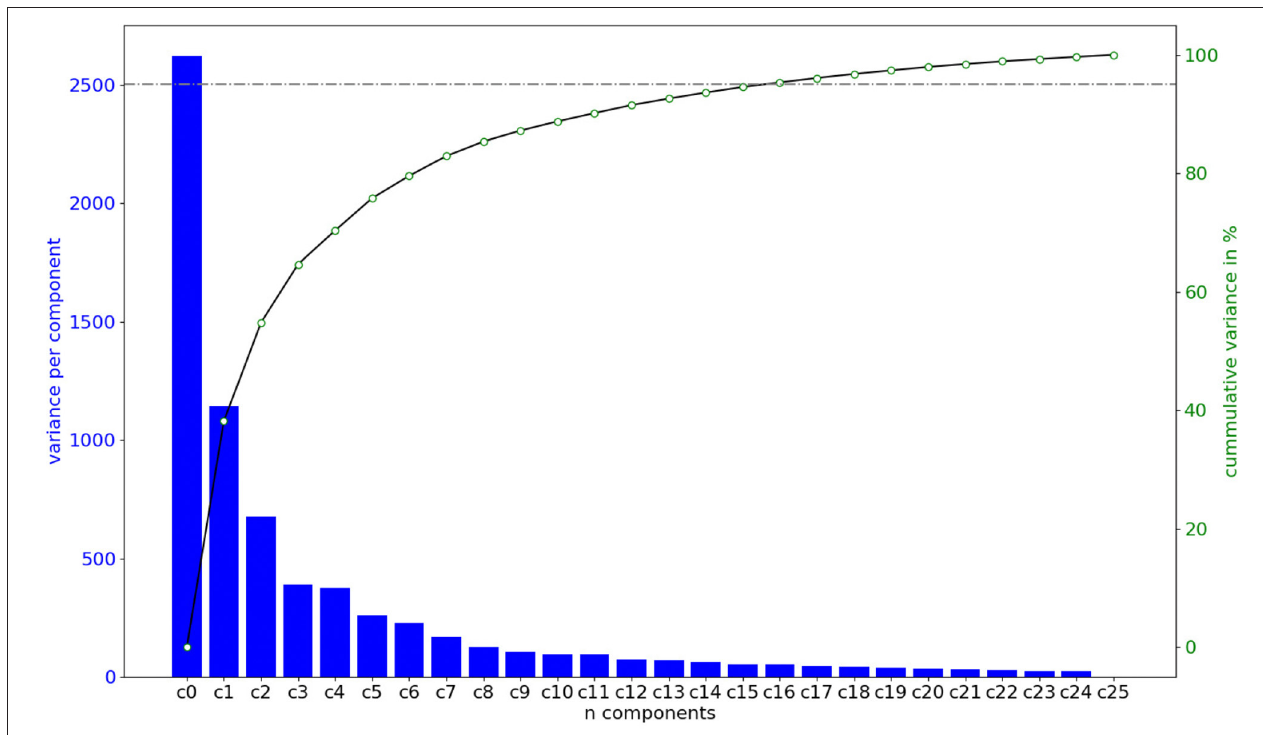
FIGURE 4 | Amount of shape variation explained by each of the components of the feature vector in the space defined by the PCA, in order of importance. Importance is computed by training a Random Forest model and computing the decrease of impurity of each subtree. The first n = 16 features are capable of explaining 95 % of the shape